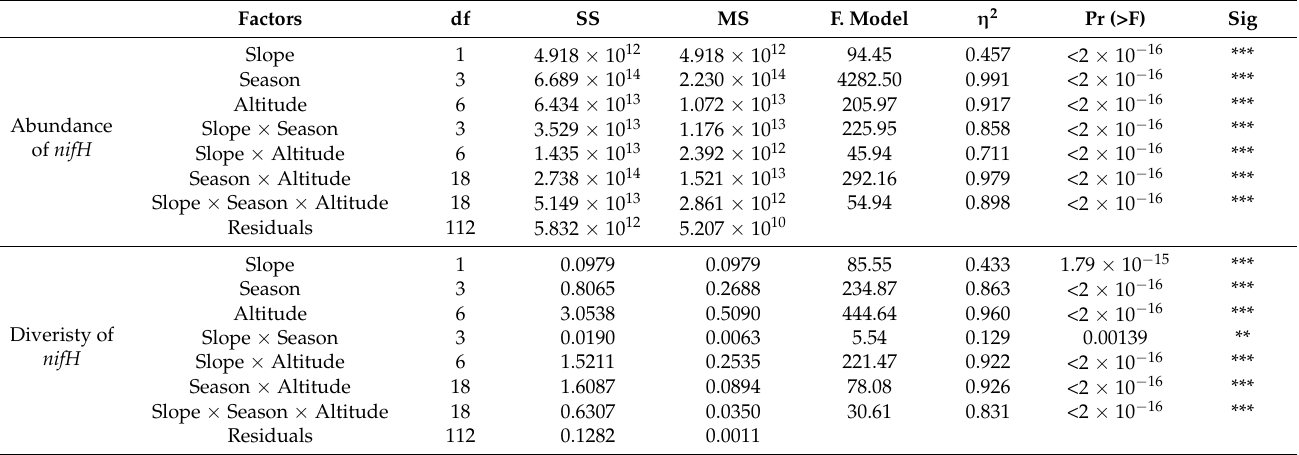
Table 3. Permutational multivariate analysis (PerMANOVA) revealing the relative contributions of slope, season and altitude and their interactions on nifH abundance and diveristy variations across all soil samples.